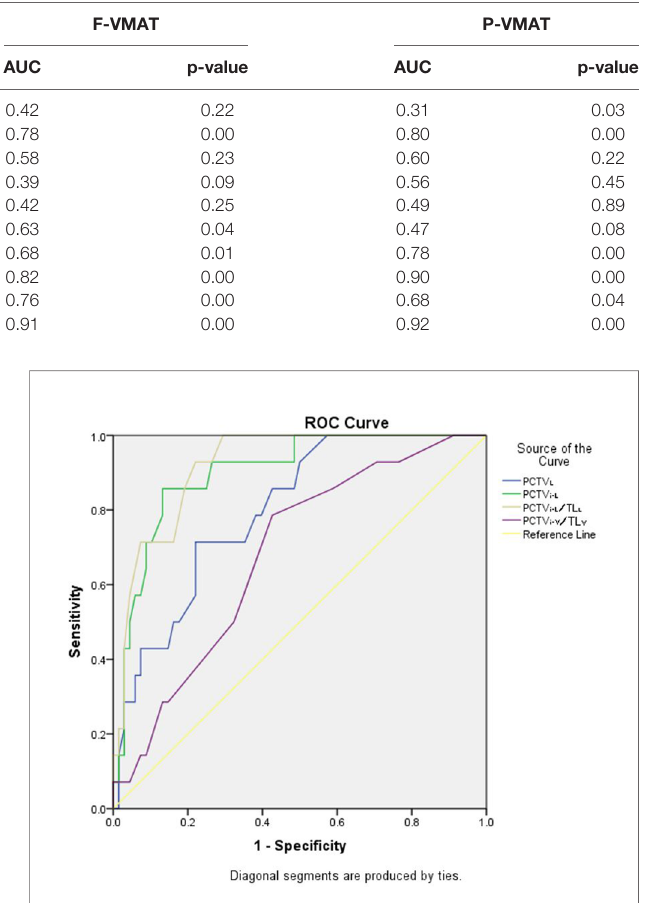
FIGURE 4 | ROC analysis curves of P-VMAT for PCTV L , PCTV i-V , PCTV i-L and PCTV i-L /TL L